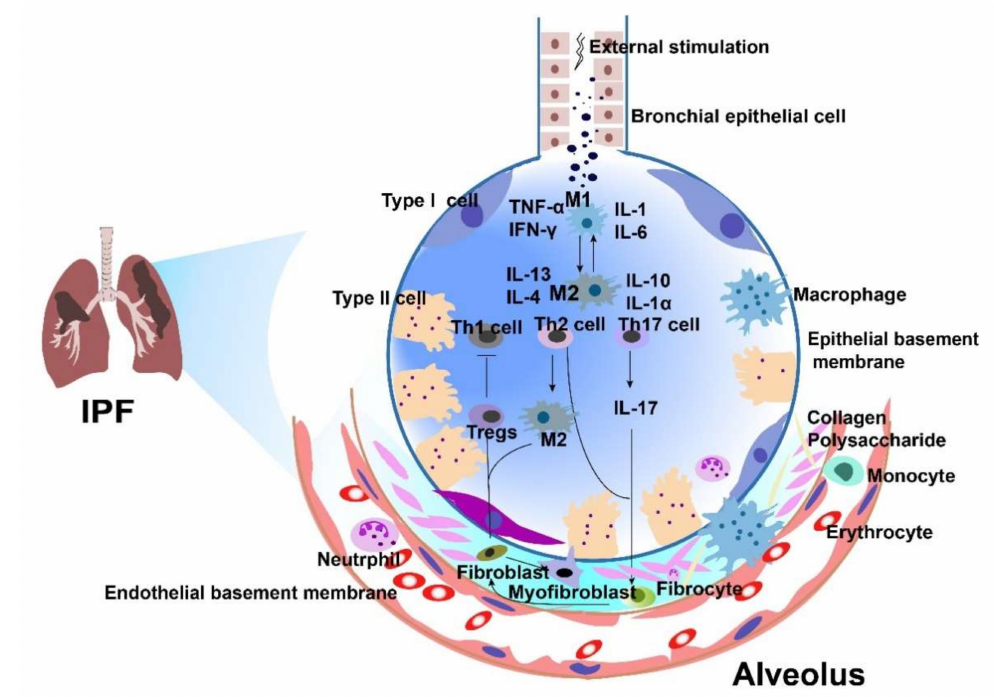
Figure 2. The dyshomeostasis of the microenvironment in idiopathic pulmonary fibrosis (IPF). In individuals with IPF, lung epithelial injury leads to the production of inflammatory factors, profibrotic cytokines, and chemokines secreted by alveolar macrophages. This results in activation of fibroblasts and differentiation into myofibroblasts, which produces extracellular matrix (ECM), leading to thickening of the lung interstitium. In IPF, the microenvironment altered the Th1/Th2 balance in the lung. IFN- γ produced by Th1 cells inhibits fibrocyte differentiation and promotes M1 macrophage formation. IL-17 production by Th17 cells in the lung also promotes fibroblast activation. The imbalance between Th17 and Tregs can affect pulmonary